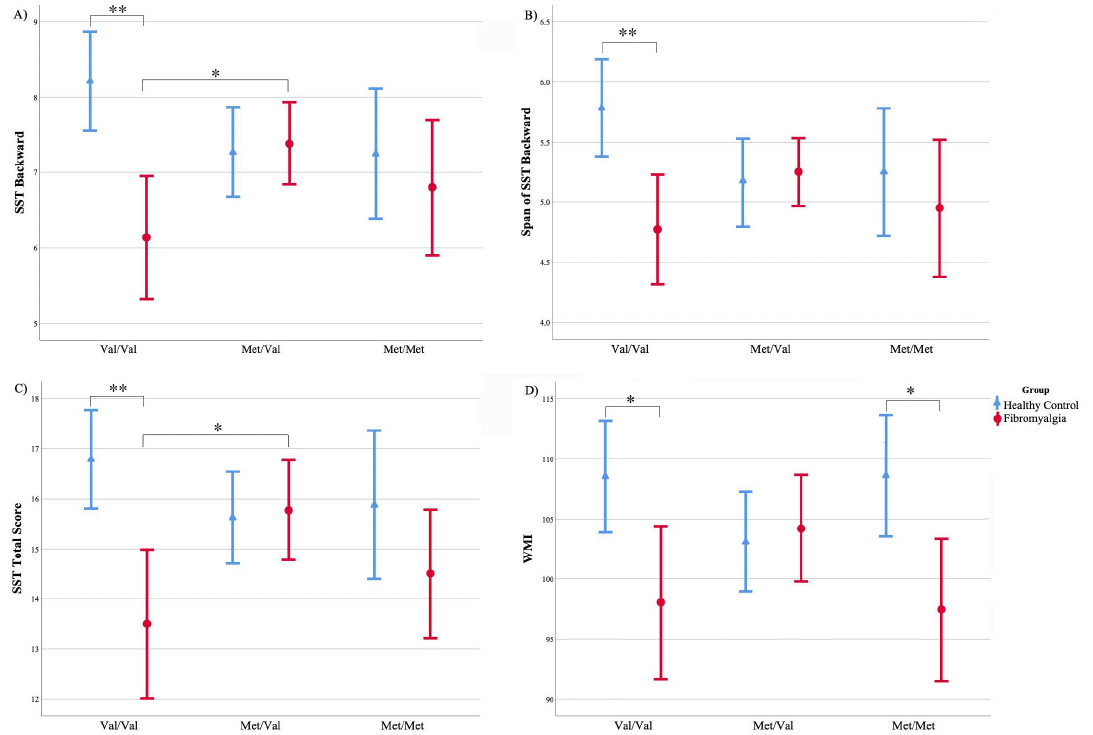
Figure 2. Means and standard errors related to the performance in the working memory tests. Data of fibromyalgia patients (red) and healthy controls (blue) are represented for each COMT genotype: Val / Val, Met / Val and Met / Met. ( A ) SST backward score, ( B ) span SST backward, ( C ) SST total score and ( D ) WMI. * p < 0.05; ** p < 0.001. SST, Spatial Span Test; WMI, Working Memory Index; Val, valine; Met,